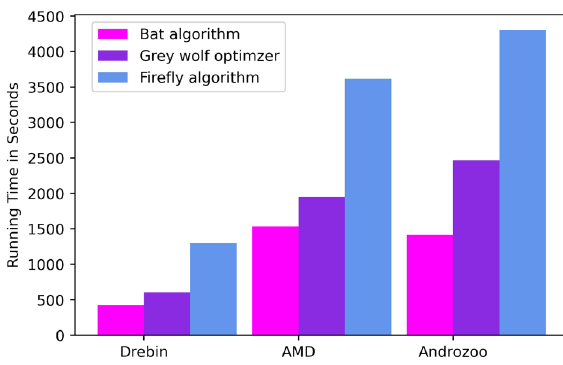
Figure 5. Running time comparison of